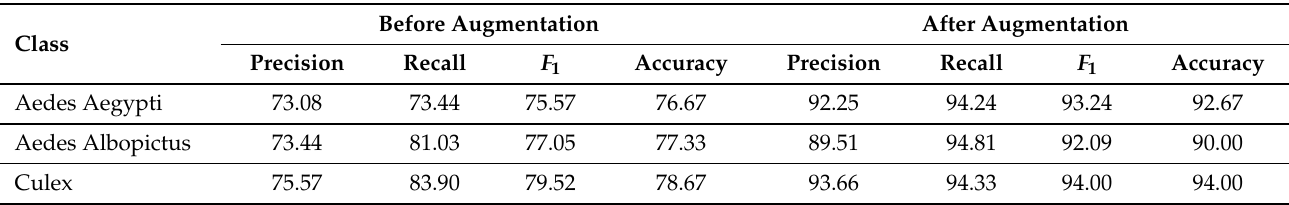
Table 3. Statistical measure results of mosquito surveillance framework